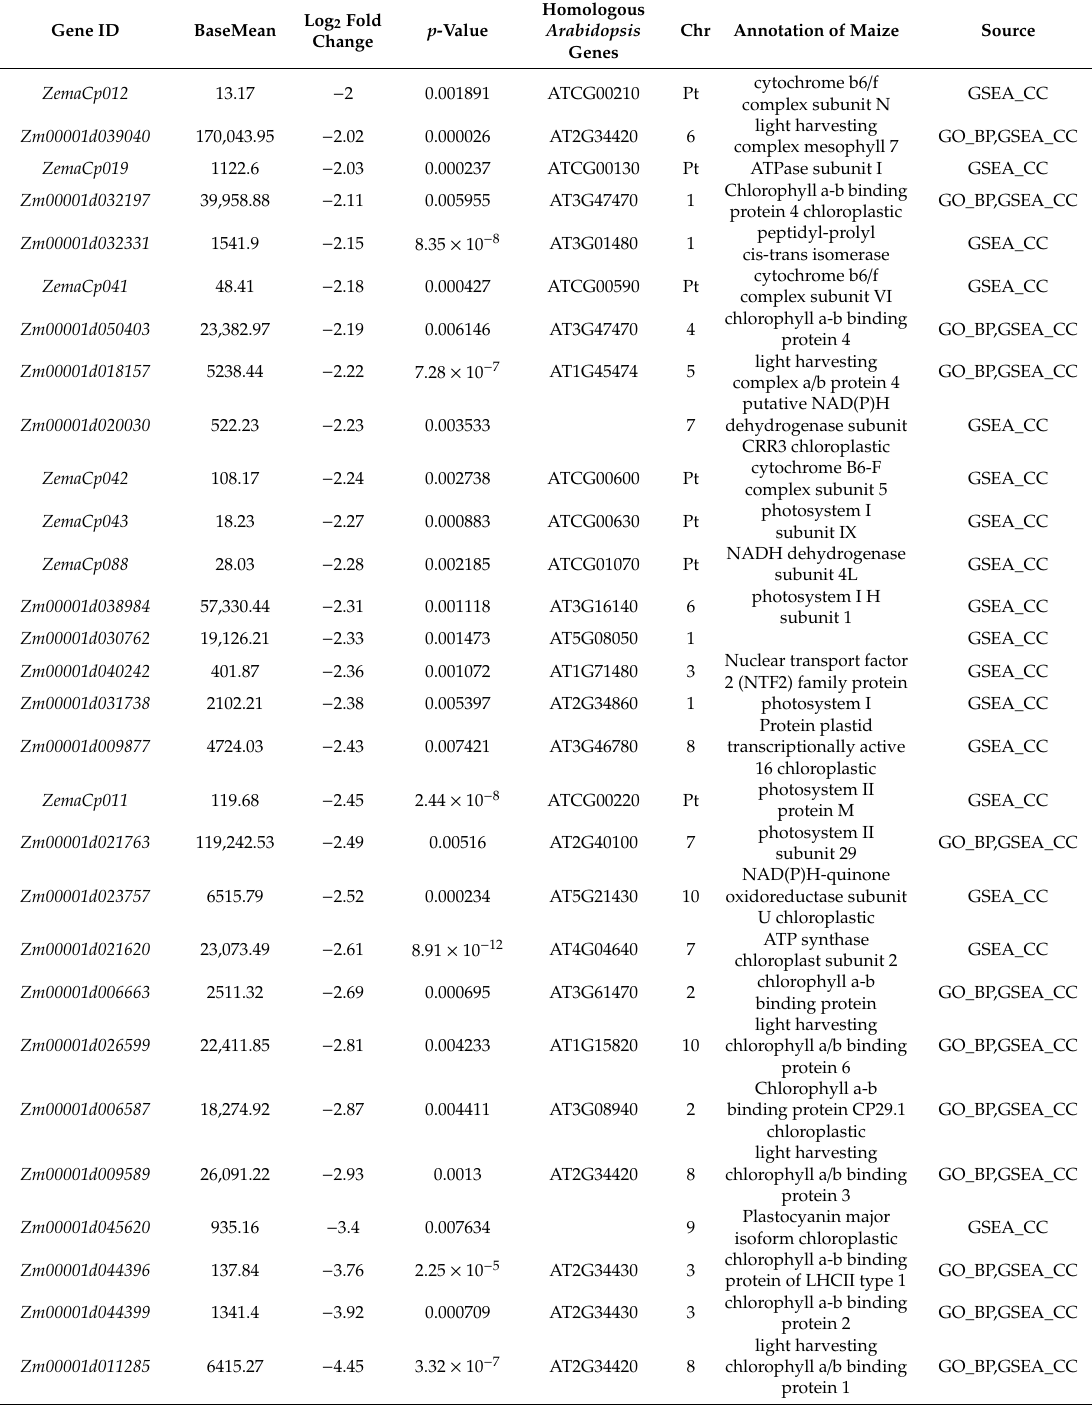
Table 2. Di ff erentially expressed genes screened by GO analysis and gene set enrichment analysis (GSEA) in ZmELS5 NILs leaf